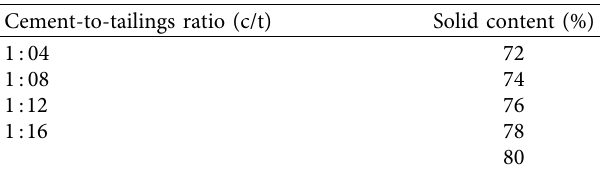
Table 3: Mix formulations of cemented unclassified tailings backfill